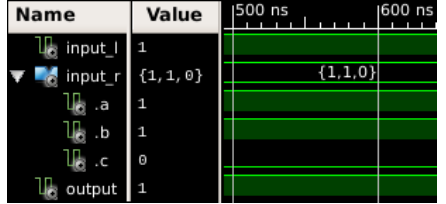
Figure 8. Simulation results of AND gate with right port hardened, with a transient error in its right